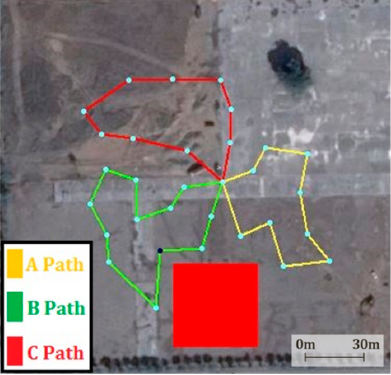
Figure 19. The shortest route programmed by the algorithm considering the no-travel zone.